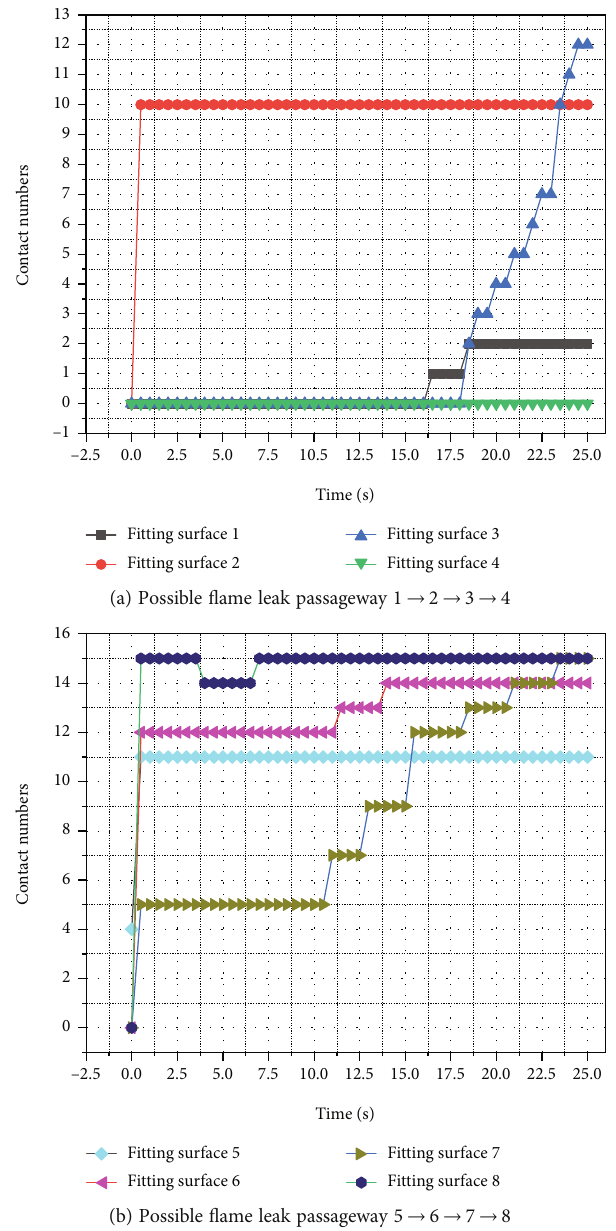
Figure 15: The history of contact number for the two possible fl ame leak passageways.